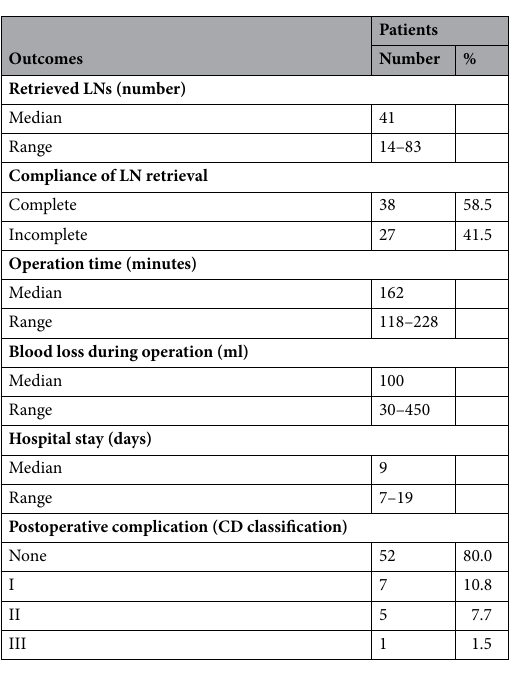
Table 2. Short-term surgical outcomes and postoperative course.